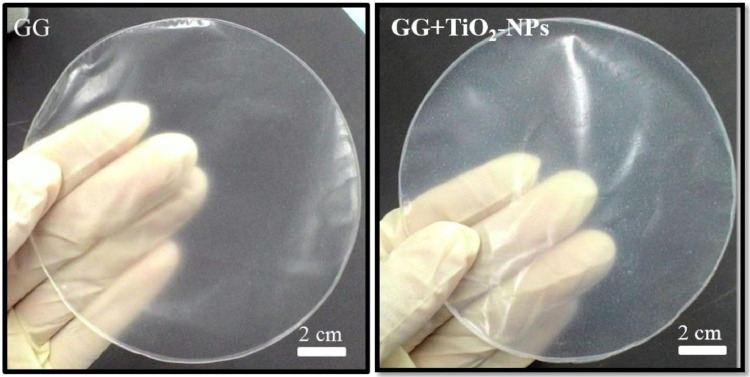
Photo images of GG and GG+TiO2-NPs biofilms.